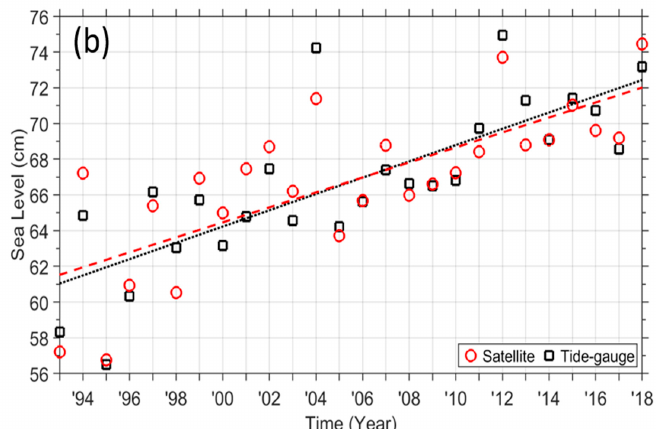
Figure 2. ( a ) Climatology of de-trended monthly mean NEAMS sea-levels from tide-gauge observations averaged from 1993 to 2018. 0 cm represents the trend line of the original tide-gauge data and the inverted barometer effect was not removed. The maximum and minimum are in August and February, respectively. Error bars indicate the positive and negative standard deviations of monthly sea-level for 26 years from climatology. ( b ) Time-series of August mean NEAMS sea-levels from satellite altimetry (red open circles) and tide-gauge observations (black open squares) from 1993 to 2018 after removing the inverted barometer e ff ect. The vertical reference datum (0 cm) of the tide-gauge data had been adjusted to have the same mean sea-level in August for 26 years between tide-gauge data and satellite altimetry, and the dashed red and black dotted lines represent their trends.